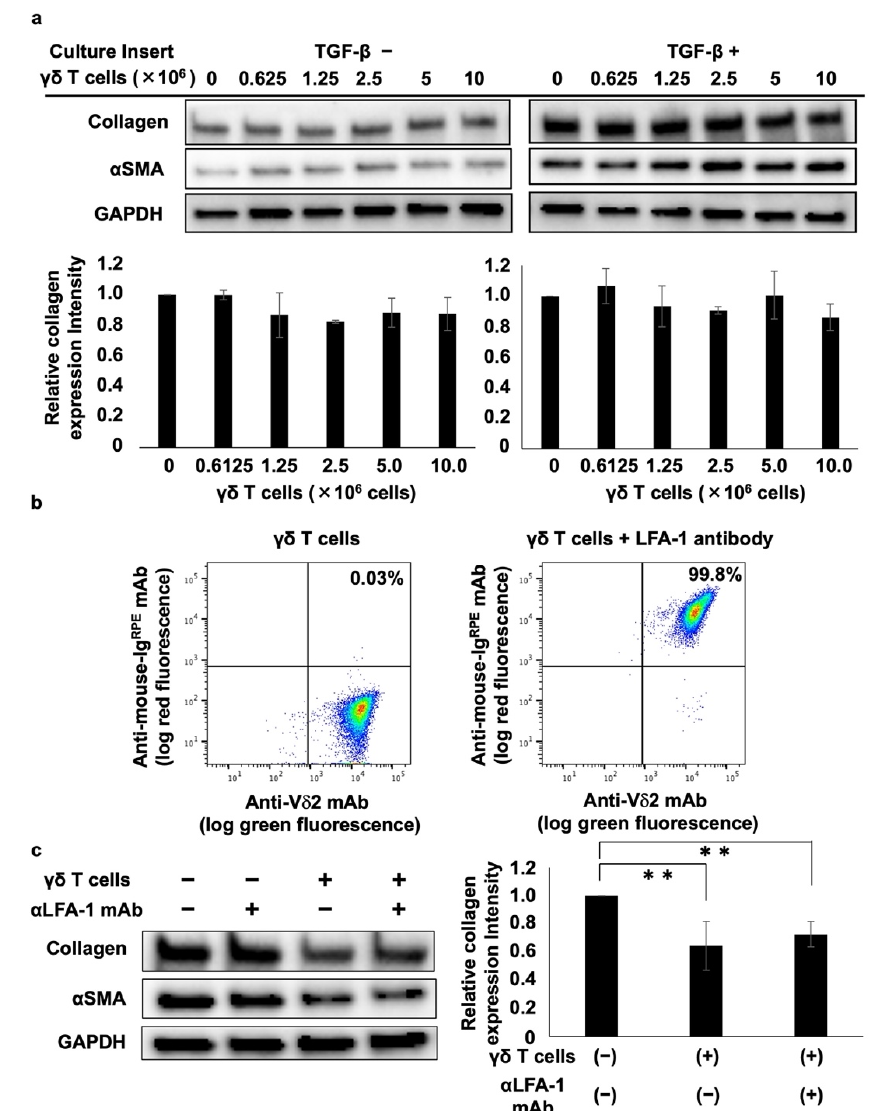
Figure 2. Cell–cell contact-dependent inhibition of collagen levels in lung fibroblasts by γδ T cells. ( a ) Effect of soluble factors derived from V γ 2V δ 2 T cells on collagen levels in lung fibroblasts. DHLF cells (1.5 × 10 5 ) were seeded in a 6-well plate and incubated overnight in the presence or absence of 5 ng/mL TGF- β . The cells were then washed with PBS (-) and culture membrane inserts attached to the wells before adding serial dilutions of γδ T cells (0, 0.625 × 10 6 , 1.25 × 10 6 , 2.5 × 10 6 , 5 × 10 6 , 10 × 10 6 cells). After incubation for 2 days, DHLF cells were dissolved in lysis buffer and collagen I and α SMA levels were determined via Western blot analysis. Relative collagen expression was measured after normalization to GAPDH expression levels. ( b ) Flow cytometric analysis of LFA-1 expression on γδ T cells. PTA/IL-2-induced γδ T cells were treated with 2 µ g/mL of anti-LFA1 mouse antibody for 30 min. After washing with PBS (-), the cells were placed on ice and stained with FITC-conjugated anti-V δ 2 mAb and R-phycoerythrin-conjugated anti-mouse Ig for 15 min. The stained cells were washed three times with PBS (-) and analyzed using a FACSLyric flow cytometer. ( c ) Effect of anti-LFA-1 mAb on γδ T cell-mediated inhibition of collagen in lung fibroblasts. DHLF cells (1.5 × 10 5 ) were cultured overnight and incubated for 2 days with γδ T cells (5 × 10 6 ) in the presence or absence of anti-LFA-1 mAb. The expression levels of collagen I and α SMA in DHLF were examined via Western blot analysis. Data are presented as mean ± standard deviation and are representatives of three independent experiments. Statistical significance was measured using Dunnett’s test (** p <